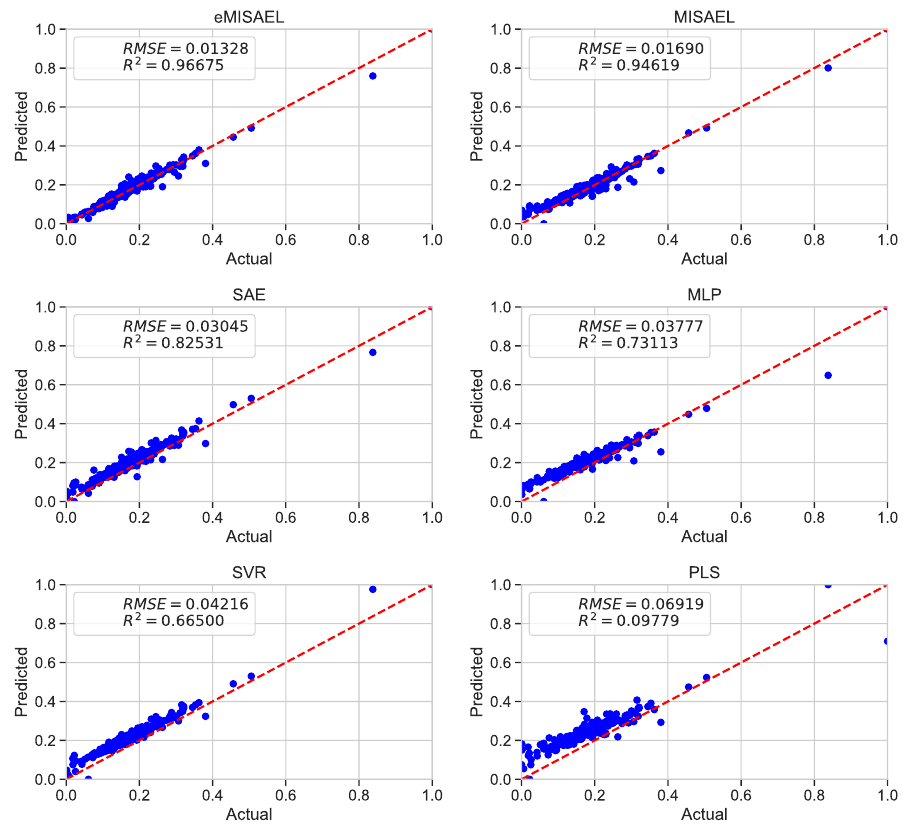
Figure 12. Real values of SO 2 and the prediction using eMISAEL, MISAEL, SAE, MLP, SVR, and PLS soft sensors.